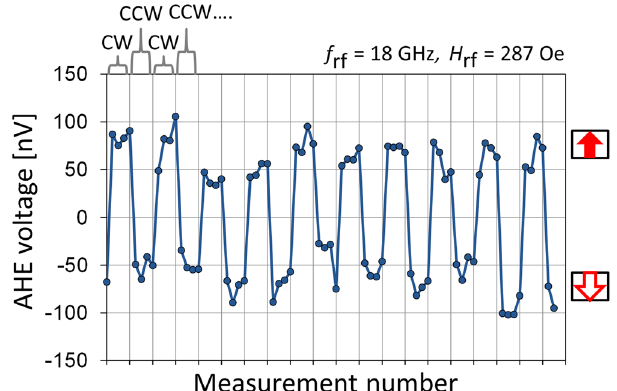
Figure 5. AHE voltage measured by applying the CP microwave field from CPWs 1 and 2 for = f 18 = H 287 Oe, and a duration of 0.5 ns. The rotation direction of the microwave field is reversed every four AHE rf